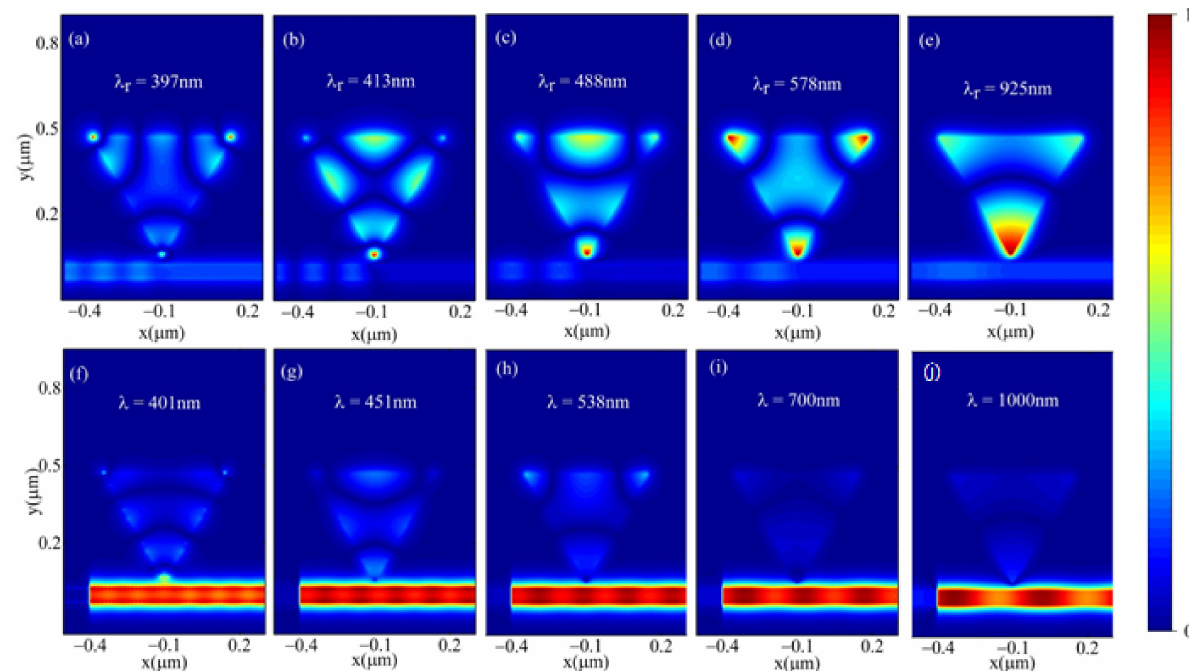
Figure 4. The magnetic distribution profile of the inverted ETSC at: ( a ) λ r = 397 nm; ( b ) λ r = 413 nm; ( c ) λ r = 488 nm; ( d ) λ r = 578 nm; ( e ) λ r = 925 nm; ( f ) λ = 401 nm; ( g ) λ = 451 nm; ( h ) λ = 538 nm; ( i ) λ = 700 nm; ( j ) λ = 1000 nm.